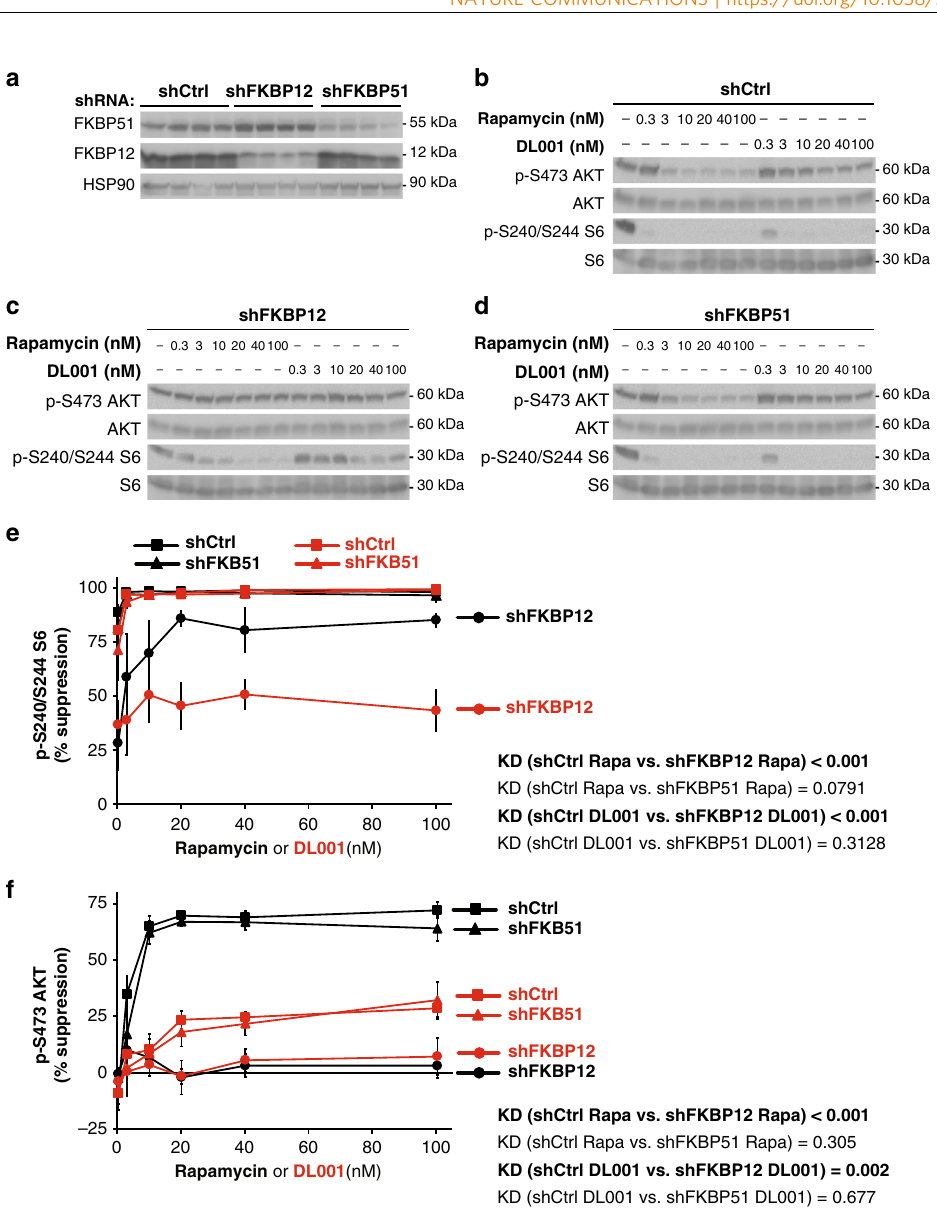
Fig. 2 DL001 is an FKBP12-dependent mTORC1 inhibitor. a Decreased protein expression of FKBP12 and FKBP51 by shRNA was veri fi ed via western blotting. b – d PC3 cells expressing b a nonspeci fi c control shRNA (shCtrl), c shRNA against FKBP12 , or d shRNA against FKBP51 were treated with rapamycin or DL001 at 0.3 – 100 nM for 48 h and the phosphorylation of S6 S240/S244 (a readout for mTORC1 activity) and AKT S473 (a mTORC2 substrate) was determined by western blotting. e – f The inhibition of e S6 S240/S244 phosphorylation and f The inhibition of AKT S473 phosphorylation was plotted ( n = 3 biologically independent experiments; statistics for the overall effects of knockdown of FKBP12 or FKBP51 represent the p -value from a two-way ANOVA). Rapamycin data are plotted in black, DL001 data plotted in red; squares represent cells expressing shCtrl, circles cells expressing shFKBP12, and triangles cells expressing shFKBP51. Error bars represent standard error. Source data are provided as a Source Data fi